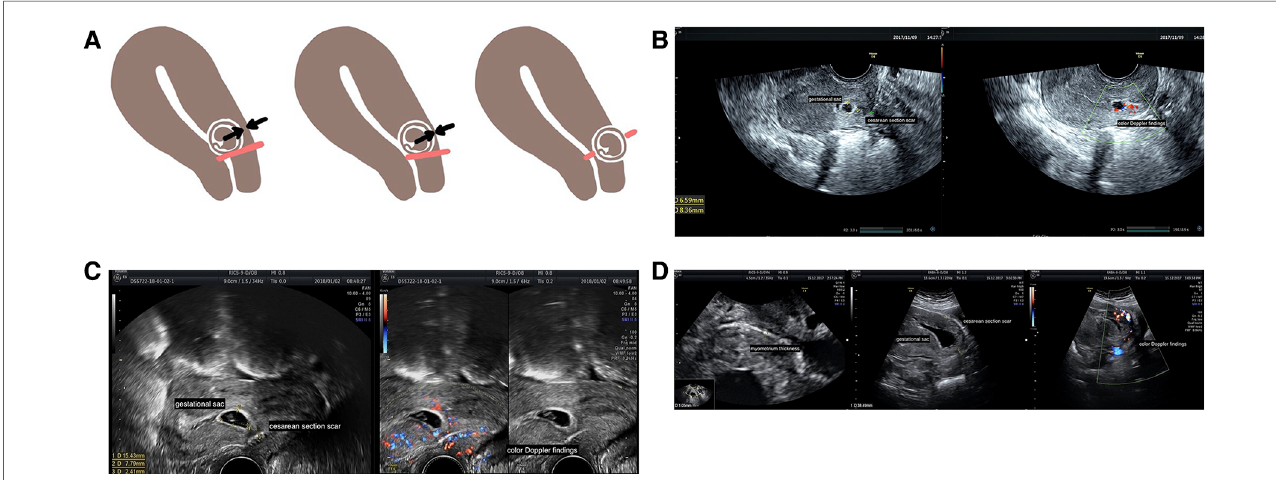
FIGURE 1 Types of CSP and their ultrasound images. ( A ) Different types of CSP. Red lines refer to the cesarean scar, black or white arrows show the thickness of the myometrium, and brown circles show gestational sacs. Type I CSP is de fi ned as a gestational sac partially located in the scar area having a myometrium thickness of >3 mm. Type II CSP is de fi ned as a gestational sac partially located in the scar area having a myometrium thickness of ≤ 3 mm. Type III CSP is de fi ned as a gestational sac completely located within the area of the scar having a myometrium thickness of ≤ 3 mm. Blood fl ow, illustrated by color fl ow Doppler, must be observed in the scar area. ( B ) Type I CSP at 7 weeks under transvaginal ultrasound. A gestational sac of approximately 8 mm×7 mm× 7 mm was partially located in the previous cesarean scar with a myometrium thickness of 8.4 mm. ( C ) Type II CSP at 7 weeks under transvaginal ultrasound. A gestational sac of approximately 15 mm×11 mm×8 mm was partially located in the previous cesarean scar with a myometrium thickness of 2.4 mm. ( D ) Type III CSP at 8 weeks under transvaginal ultrasound. A gestational sac of approximately 30 mm×40 mm×24 mm that is completely located within the previous cesarean scar with a myometrium thickness of 1.05 mm. CSP, cesarean scar